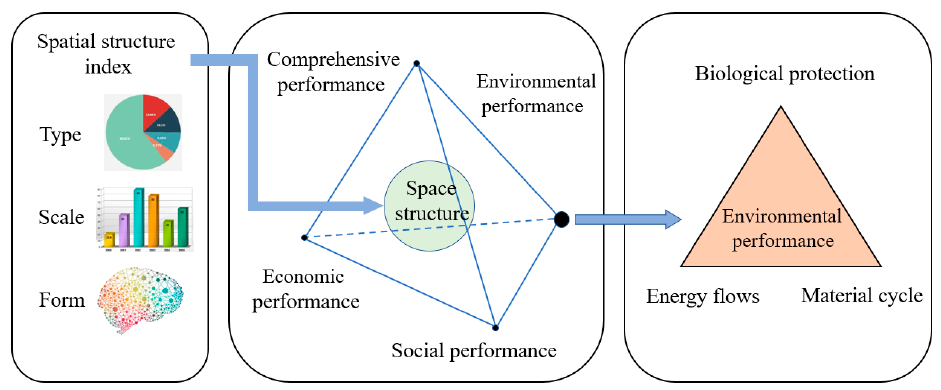
Figure 2. The relationship between energy mix and environmental performance.